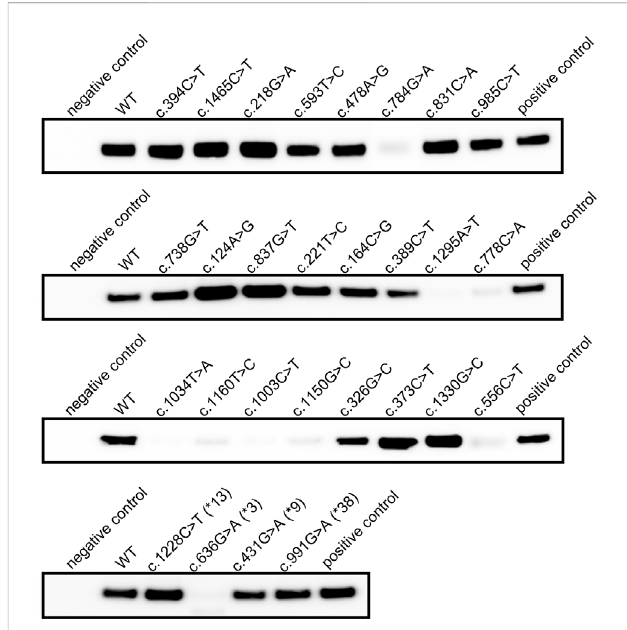
FIGURE 2 Immunoblot result of recombinant CYP2C19 extracted from human microsomal membrane. Immunoblot analysis of recombinant CYP2C19 extracted from microsomal extracts. SPMED ™ Human Recombinant Enzymes CYP2C19 (SBC02C190, SPMED Co., Ltd., Busan, South Korea) was used as positive control and empty vector as negative